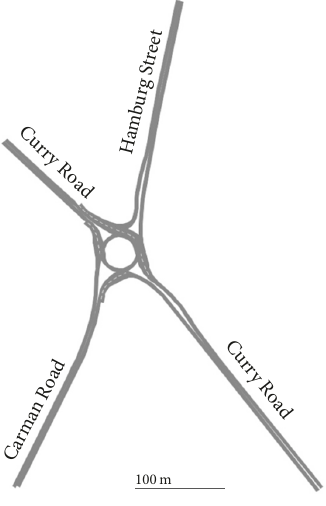
Figure 5: Roundabout case